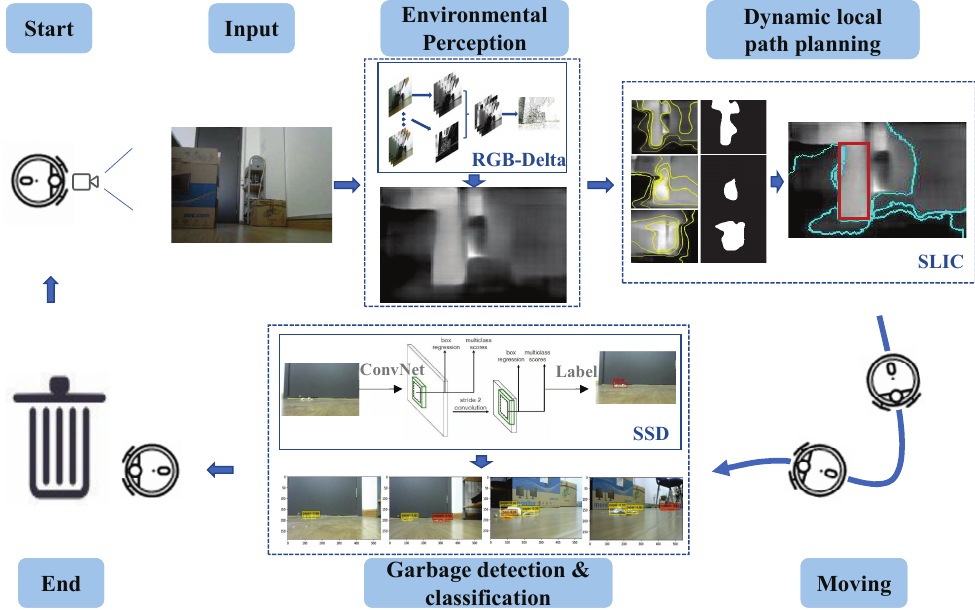
Figure 2. The workflow of the autonomous visual navigation sweeping